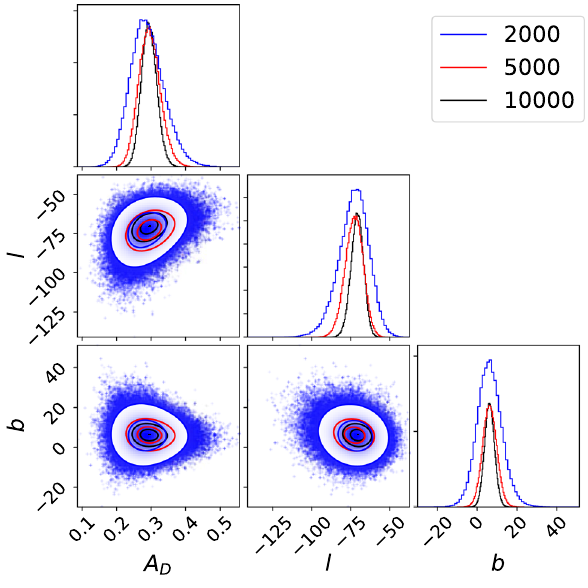
Fig. 5 Themarginalizedposteriordistributionofthedipoleparameters in the Finslerian cosmological model with the quasar dataset simulated from the 2015 quasar compilation. The horizontal and vertical solid lines denote the maximum of 1-dimensional marginalized posteriors. Theblue,red,anddarklinesdenote2000,5000and,10,000simulations, respectively Table3 The68%confidencelevelconstraintsonthedipoleparameters in the Finslerian cosmological model with the quasar dataset simulated from the 2015 quasar compilation